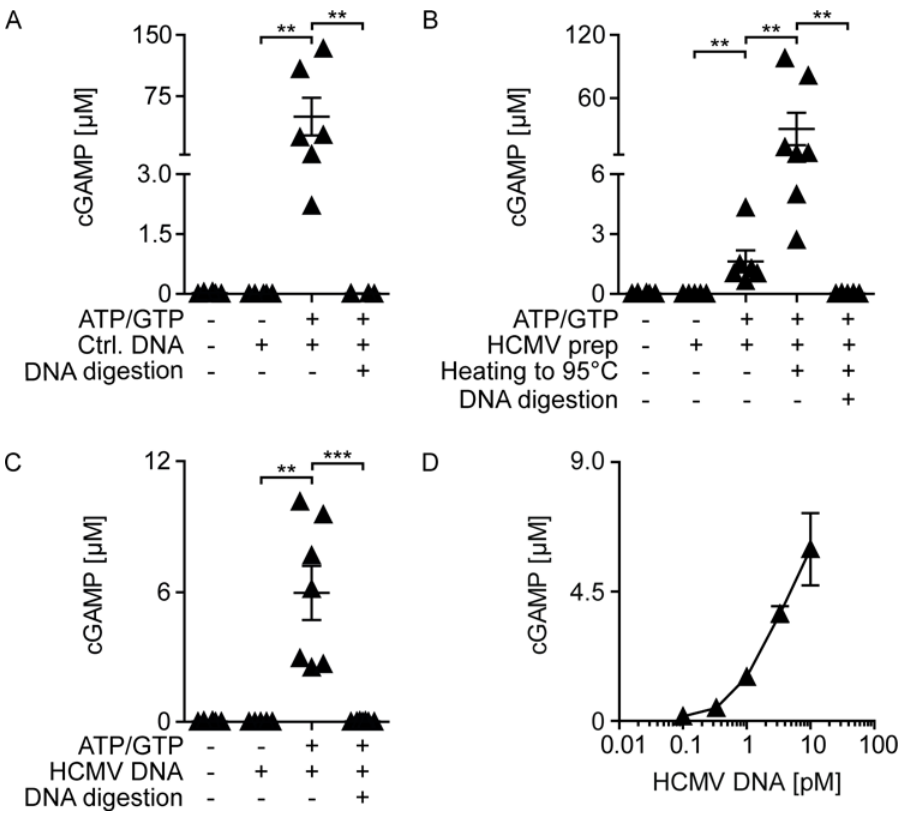
Fig 4. HCMV-derived genomic DNA efficiently activates recombinant human cGAS. Recombinant human cGAS was incubated for 2 h in the presence or absence of ATP and GTP with (A) a 50 bp long control dsDNA, (B) purified HCMV containing approximately 6.5 x 10 6 infectious virus particles, or purified HCMV treated for 10 minutes at 95°C, or (C, D) genomic DNA isolated from purified HCMV. All samples were tested with and without DNA digestion prior to incubation with recombinant cGAS. cGAMP formation was quantified using a HPLC-MS/MS method. Mean ± SEM of 5 – 6 (A) and 5 – 7 (B, C, D) data points from 3 independent experiments. ** : p (cid:1) 0.005, *** : p (cid:1) 0.0003 one-tailed Mann-Whitney